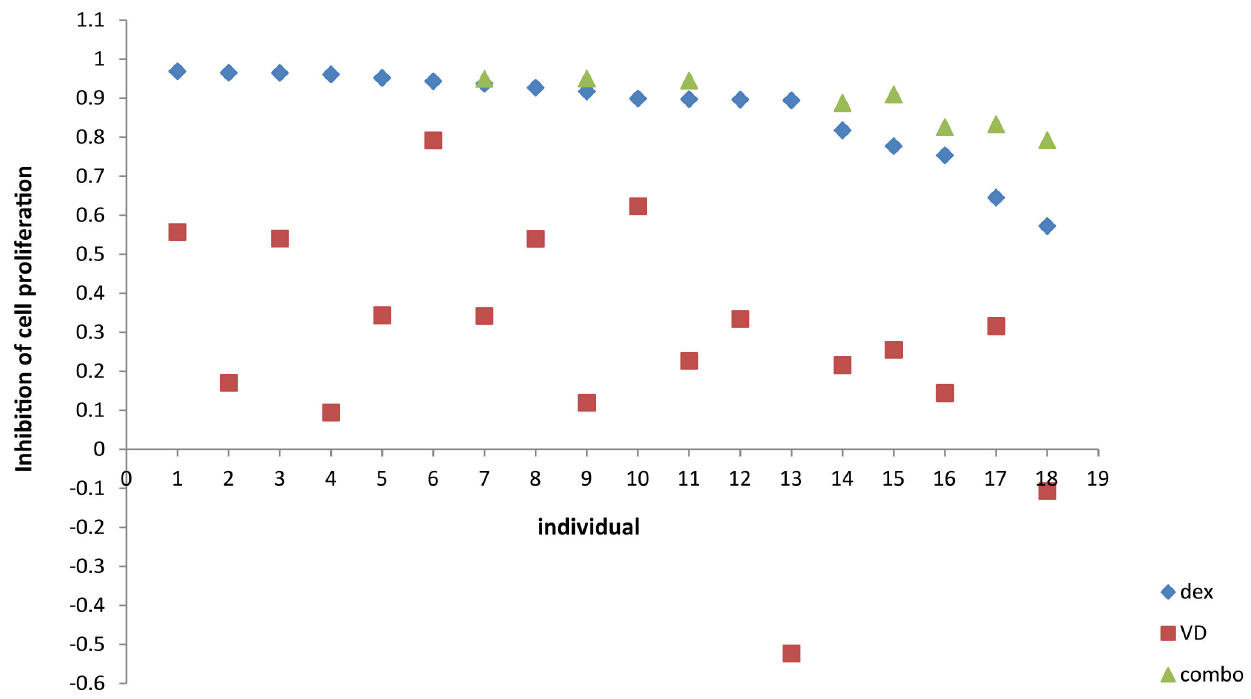
Figure 1. Scatterplot of inhibition of cell proliferation by individual and treatment. All individuals were treated with dexamethasone (diamond) and 1,25 vitamin D (square). Eight individuals who were least responsive to dexamethasone and for whom sufficient cells were available were treated with both dexamethasone and 1,25 vitamin D (triangle). Individuals treated with both hormones had higher % inhibition compared to either treatment